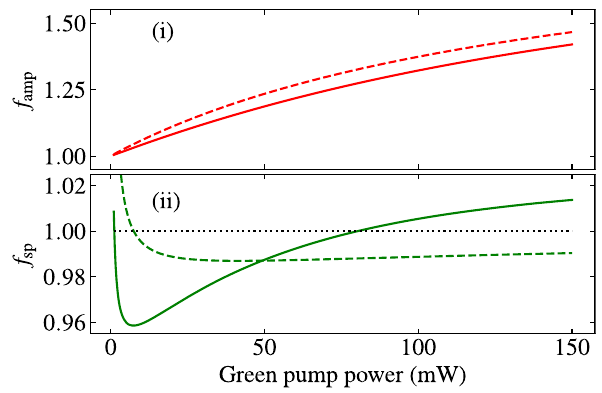
Figure 6: f amp and f sp from the qualitative model as a function of green pump power in (i) and (ii), respectively. The solid curves correspond to the case with charge state switching, and the dashed curves correspond to without charge state switching with only NV − . The black dotted line is the reference line at factor